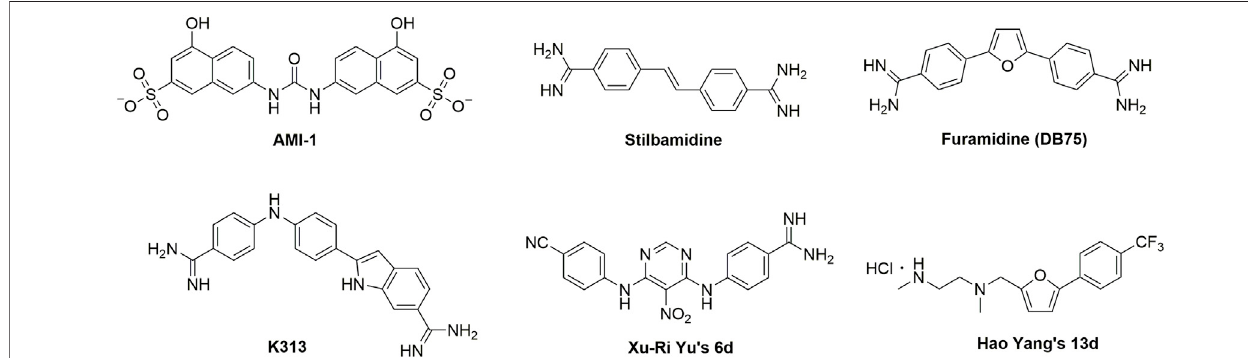
FIGURE 1 | The chemical structures of the typical reported PRMT1